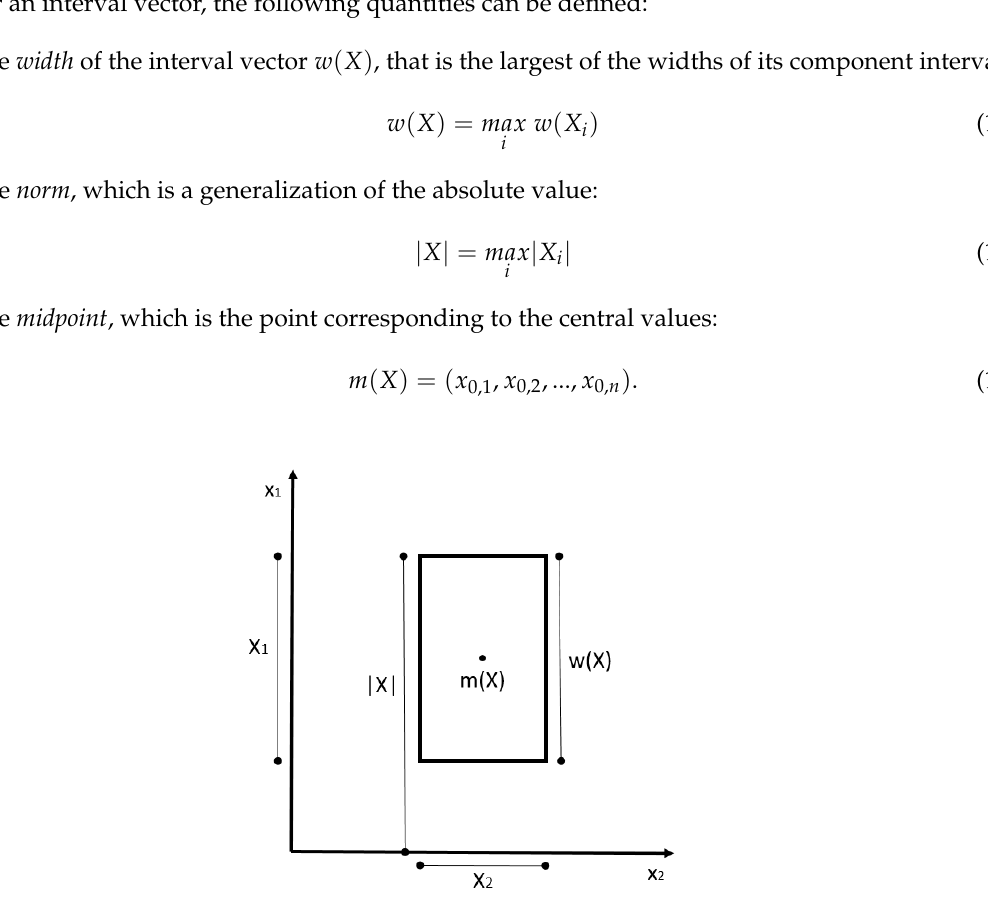
Figure 2. Interval vector with its norm, width and